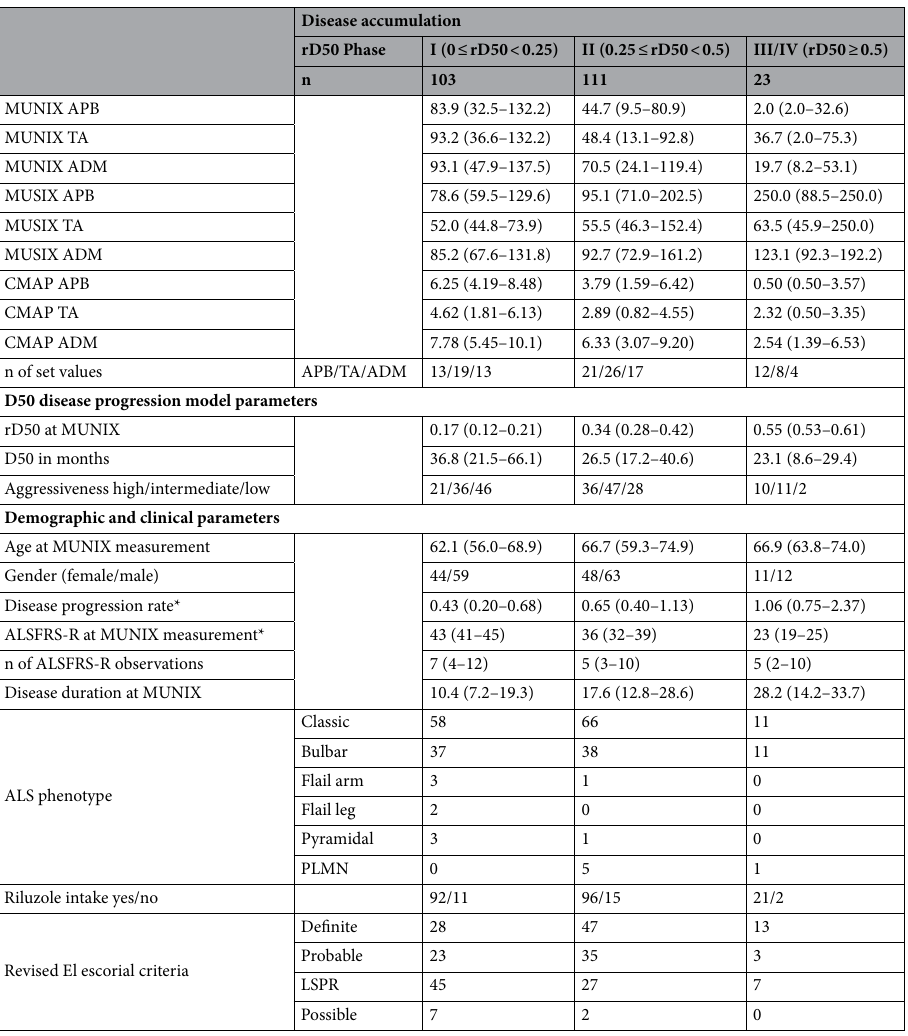
Table 2. Clinical parameters of the ALS MUNIX cohort. Values are given as median and interquartile range or numbers. ADM abductor digiti minimi, ALS amyotrophic lateral sclerosis, APB abductor pollicis brevis, CMAP patients in whom the range between MUNIX and ALSFRS-R was 0 ± 4 weeks. ALS phenotypes in accordance to Chio et al. 29